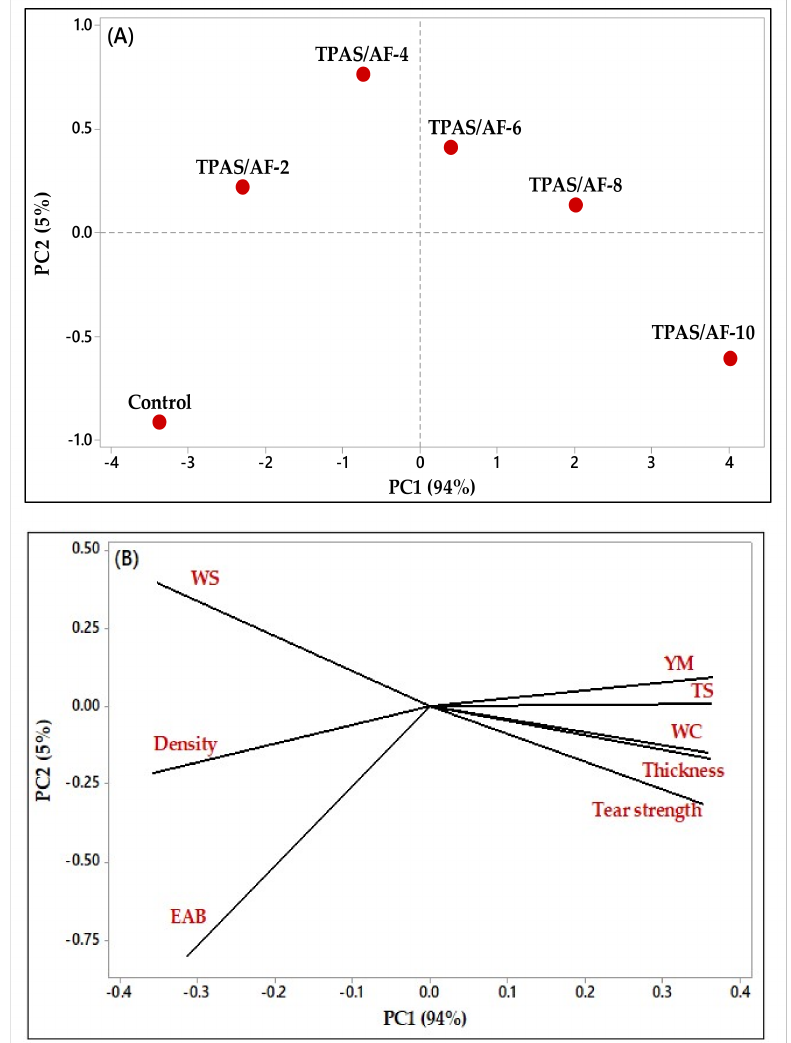
Figure 7. Plotting of the observations related to the physical and mechanical properties data of the variables (Control TPAS, TPAS/AF-2, TPAS/AF-4, TPAS/AF-6, TPAS/AF-8, and TPAS/AF-10) loaded on the multi-dimensional space of PCA as principal component 1 and 2 (PC1 and PC2). Specifically, 94% on PC1 and 5% on PC2 are loaded. ( A ) the location of different fiber loading; ( B ) the location of different physical and mechanical